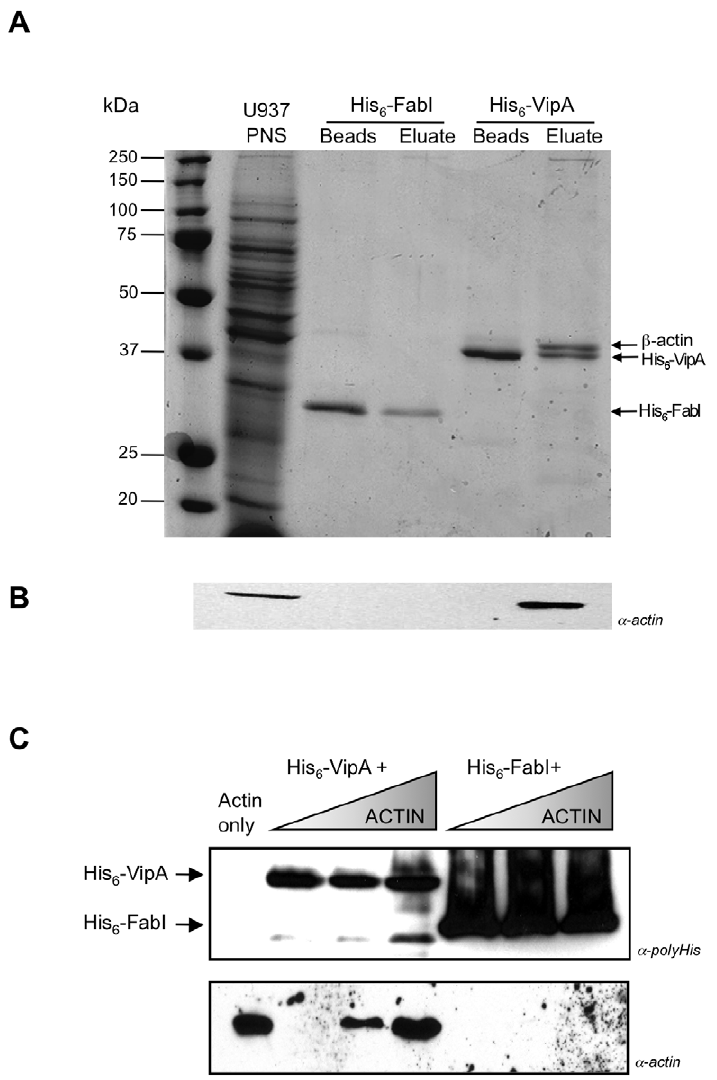
Figure 1. Invitro interaction analysis between His 6 -VipA and actin by pull-down assays. A. U937 cell Post-Nuclear Supernatants (U937 PNS) were incubated with Ni-NTA agarose beads preloaded with His 6 -VipA or His 6 -FabI (see Materials and Methods for details). After washing, bound proteins were eluted with 500 mM Imidazole. Samples containing preloaded beads or eluates were resolved by SDS-PAGE and bands visualized by Coomassie staining. The differential band appearing in the VipA eluate (arrow) was excised and identified by LC/MS as b -actin. B. Similarly prepared samples were resolved by SDS-PAGE, transferred to nitrocellulose and immunoblotted with an anti-actin monoclonal antibody ( a -actin). C. Ni-NTA agarose beads preloaded with His 6 -FabI or His 6 -VipA were incubated with increasing concentrations of purified G-actin, washed and eluted. Eluates were resolved by SDS-PAGE, transferred to nitrocellulose and Western-blotted with an anti-histidine antibody ( a -polyHis, panel above) or an anti-actin monoclonal antibody ( a -actin, panel